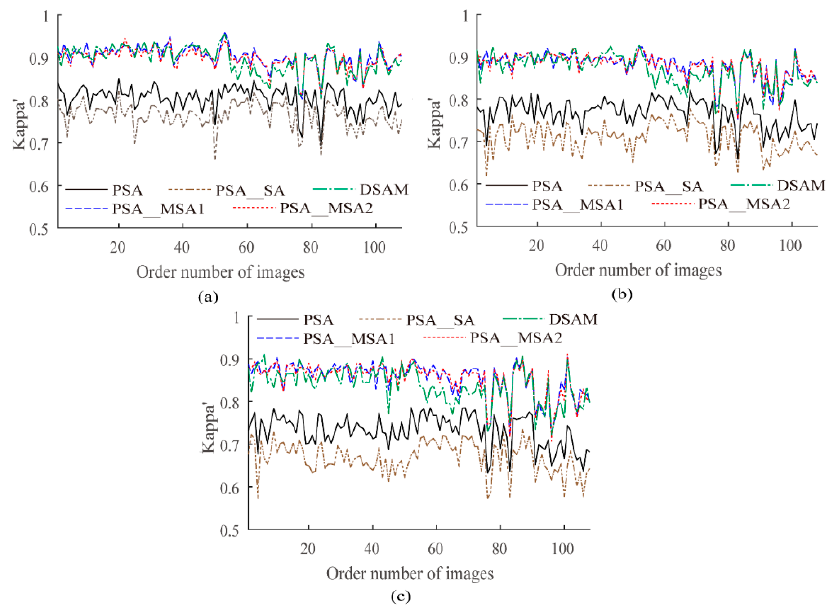
Figure 9. The improved Kappa’ values (%) of different algorithms for the synthetic data set. ( a ) S = 8, ( b ) S = 10, ( c ) S = 12.